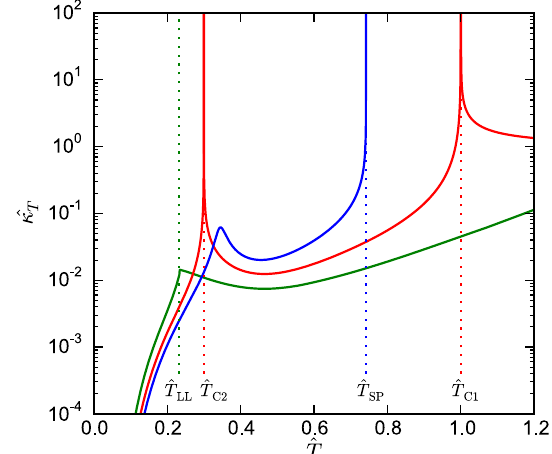
FIG. 2. The dimensionless isothermal compressibility ˆ κ T ¼ ρ − 1 ð ∂ ρ = ∂ ˆ p Þ along three selected isobars: above the liquid-liquid critical pressure, assigned equal to thevapor-liquid critical pressure (green line), at the critical pressure (red line), and below the critical pressure (blue line). liquidandliquid-liquidcriticaltemperatures, temperature oftheliquid-liquidtransitionat the selectedisobar. T is the temperature of the vapor-liquid